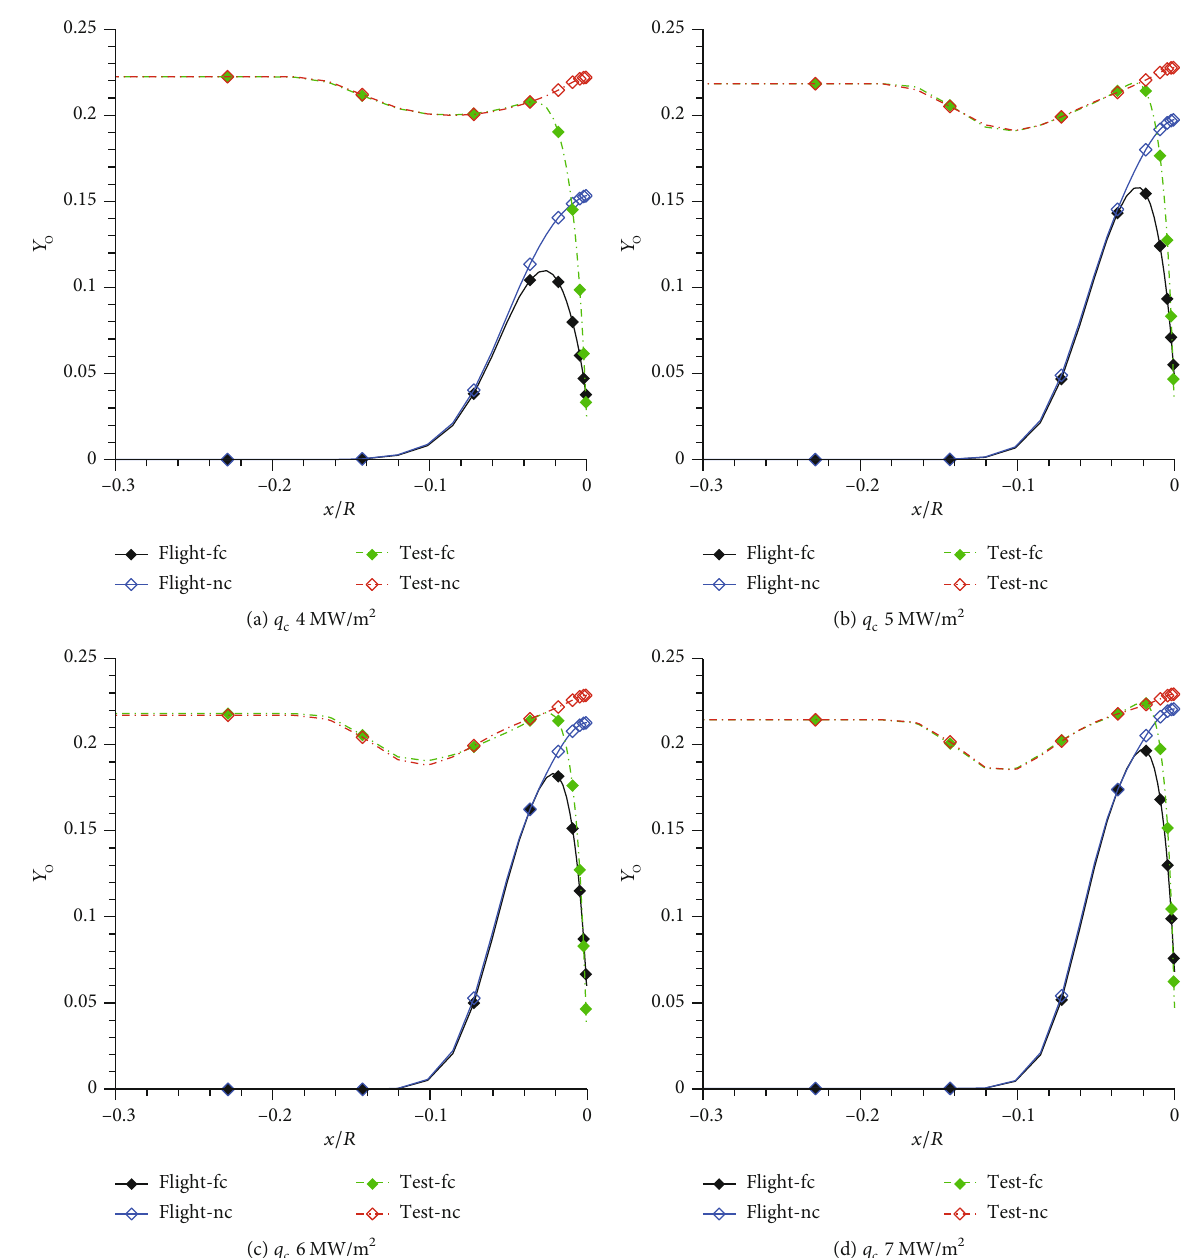
Figure 9: Comparison of oxygen atom mass fractions on the stagnation line for enthalpy 16